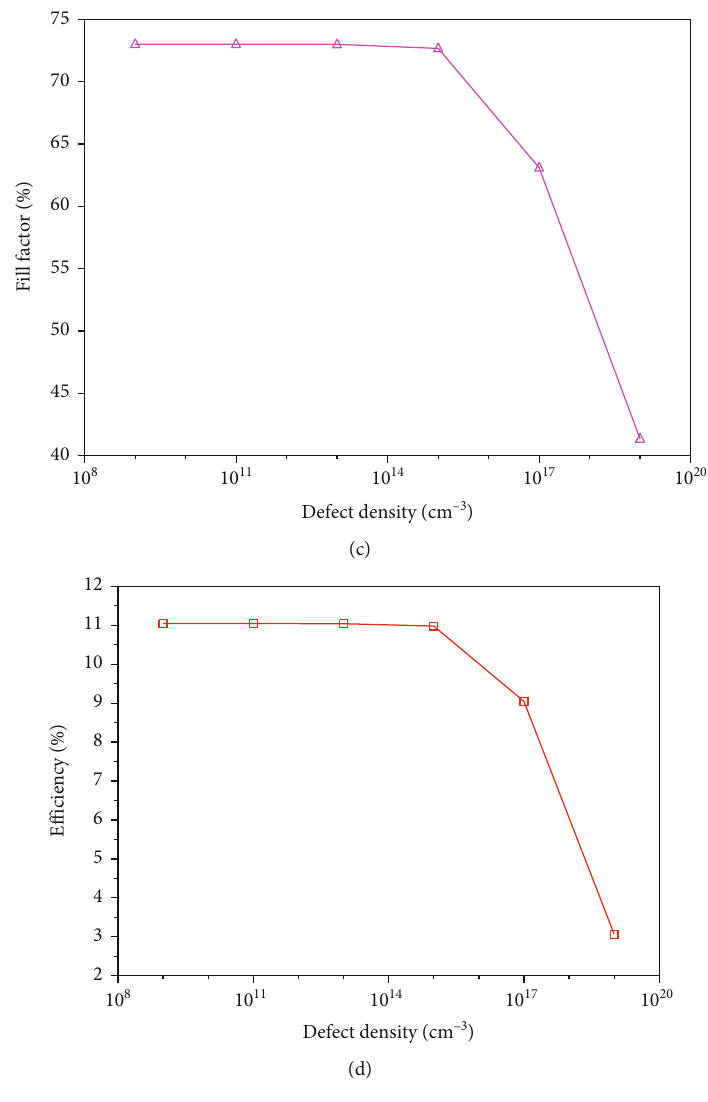
Figure 5: In fl uence of the variation of the bulk defect density of the intrinsic layer i -(a-Si:H) on the electrical parameters: (a) J FF, and (d) η .